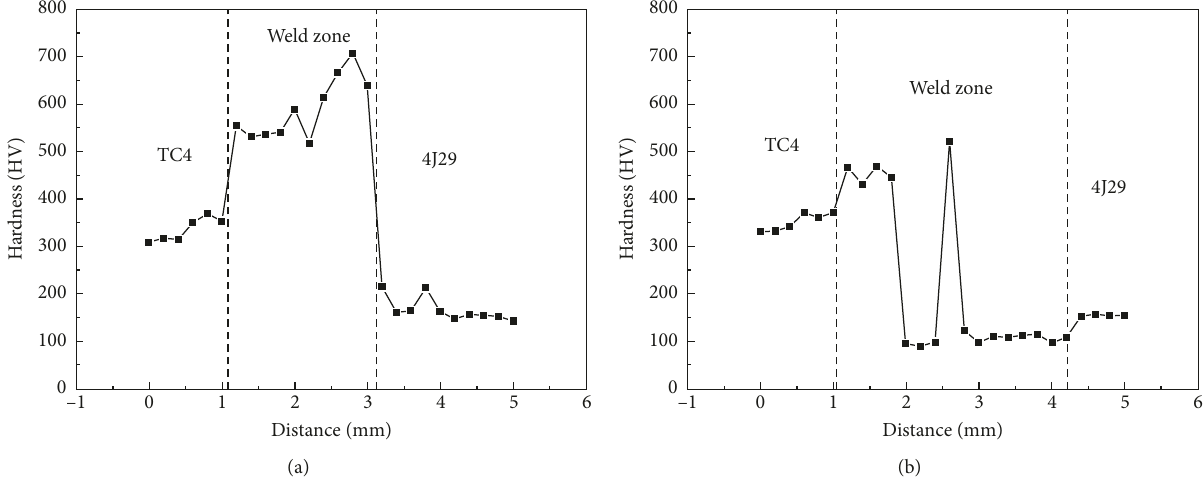
Figure 7: Microhardness distribution across the cross section of welded joints: (a) EBW-1; (b)